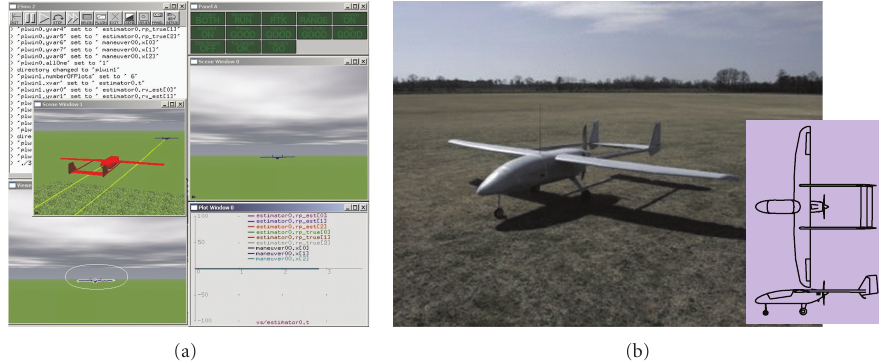
Figure 3: (a) 6 DoF Multiairplane Flight Simulation Interface, (b) MURI research airplane.